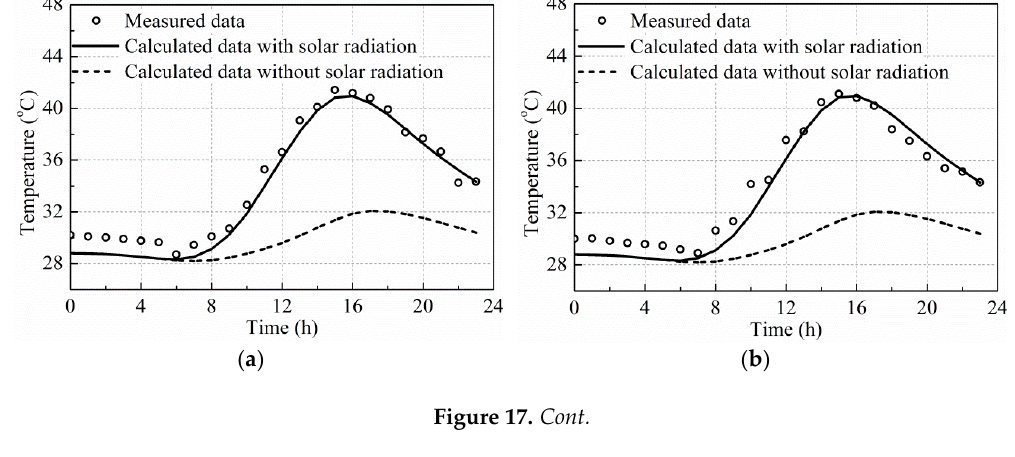
Figure 16. Finite element model of cross-section of side-by-side box girder.